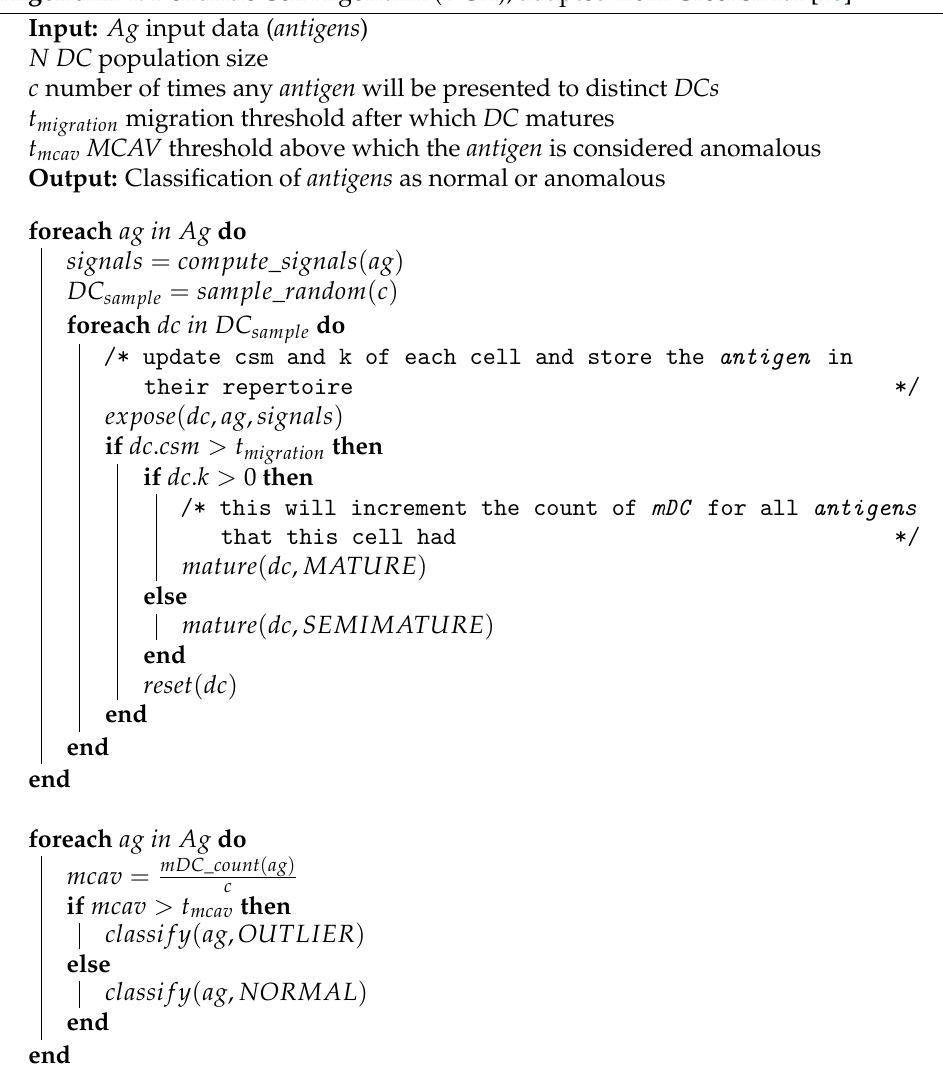
Algorithm 4: Dendritic Cell Algorithm (DCA), adapted from Greensmith